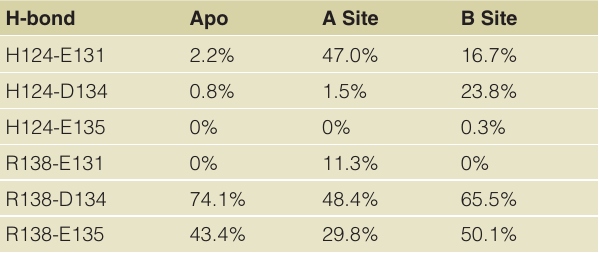
Table 2. H124, which interacts with substrate in the hsRNH complex and is known to be associated with product release, forms hydrogen bonds with D134 in the B site trajectory, partially displacing one of Table 2. Hydrogen bond occupancy in the network surrounding D134 in